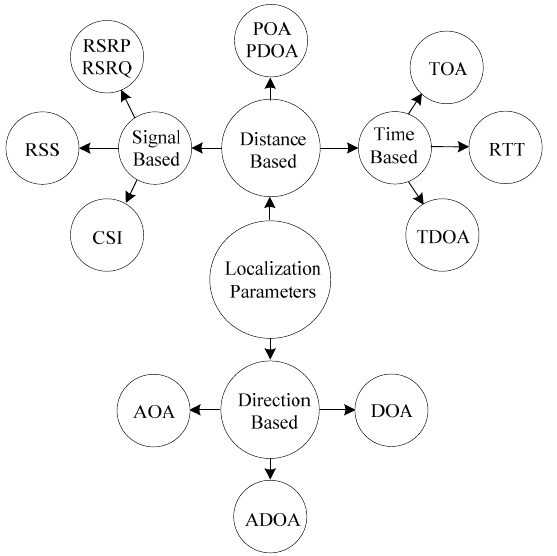
Figure 1. Localization system parameters for distance and direction measurement.